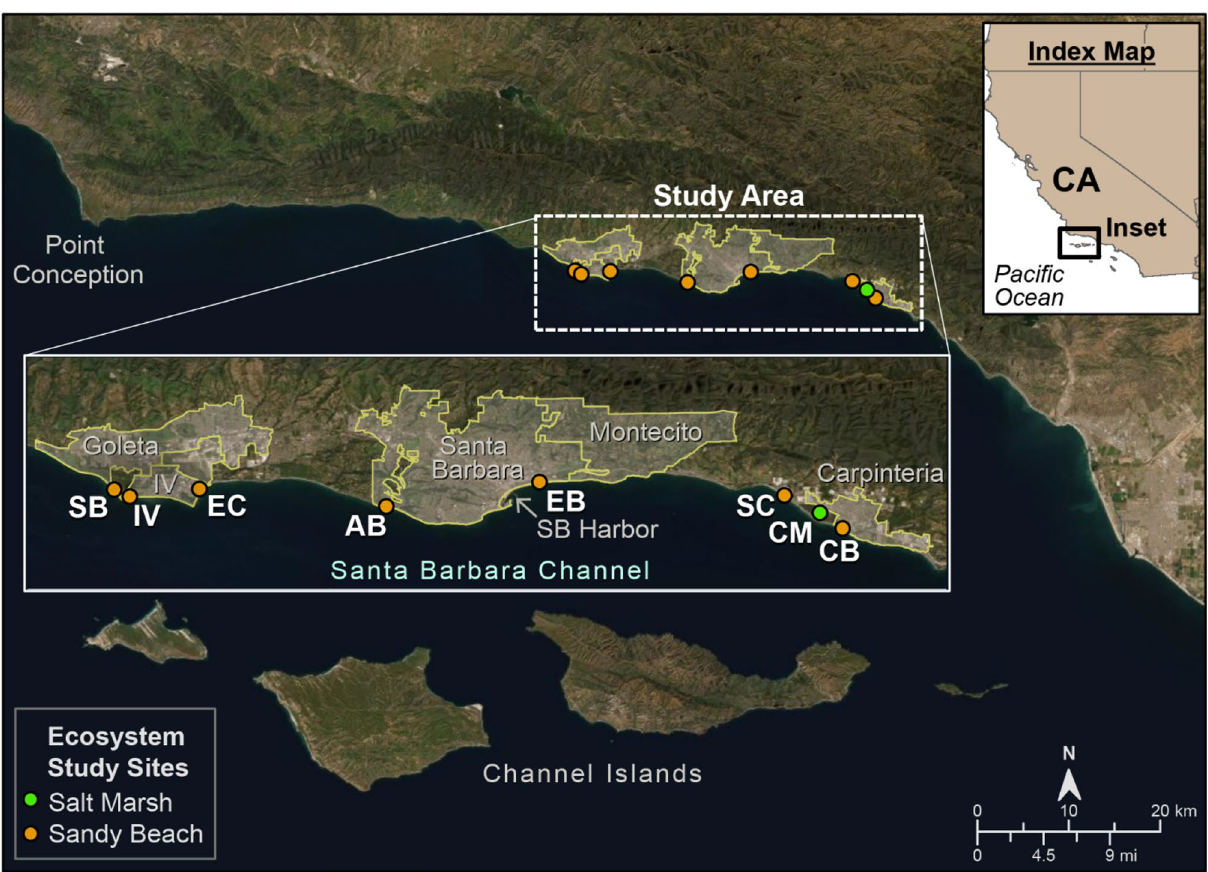
Figure 1. Study area. Projections of coastal change were conducted from Point Conception east to the Santa Barbara County line, just east of Carpinteria, California. Inset shows location of tidal marsh and sandy beach ecosystem study sites (SB = Sands/Ellwood beach, IV = Isla Vista, EC = East Campus, AB = Arroyo Burro, EB = East Beach, SC = Santa Claus, CM = Carpinteria salt marsh, and CB = Carpinteria city beach). Map also identifies the communities used to characterize socioeconomic exposure to projected flooding, including Goleta, Isla Vista, Santa Barbara (city), Montecito, and Carpinteria. (Figure generated using ArcGIS v.